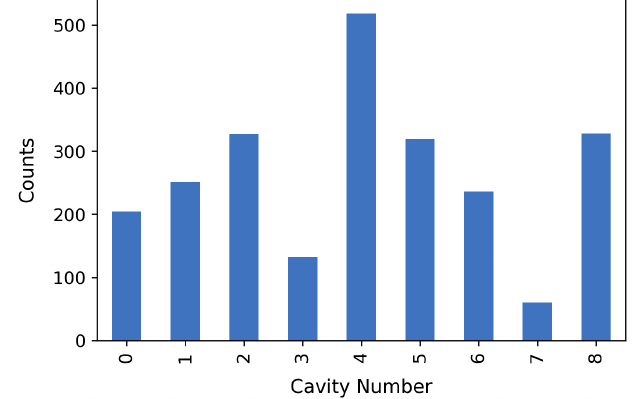
FIG. 3. Histogram showing the distribution of fault events by cavity identification. Numbers 1 – 8 correspond to unique cavity locations within a cryomodule, and cavity 0 corresponds to instances where all cavities tripped off